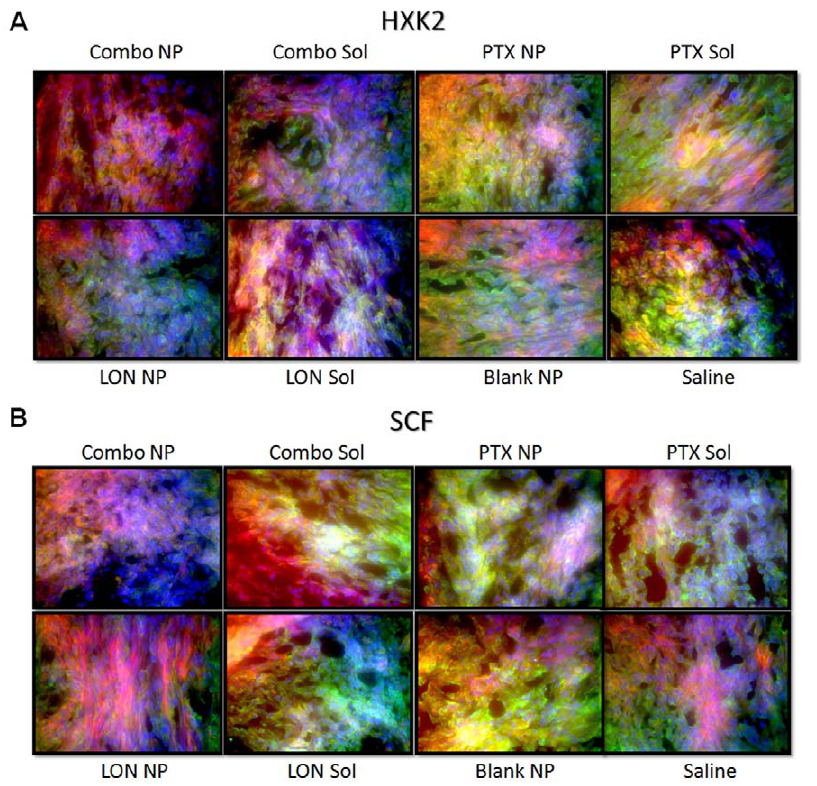
Figure 8. Immunohistochemistry of HXK2 and SCF. Tissue sections were probed with primary antibodies against the protein of interest, then labeled with Alexa Fluor H 488 conjugated secondary antibodies (green). F-actin was stained with Alexa Fluor H 568 phalloidin (red) and nuclei were stained with Hoechst 33342 (blue).